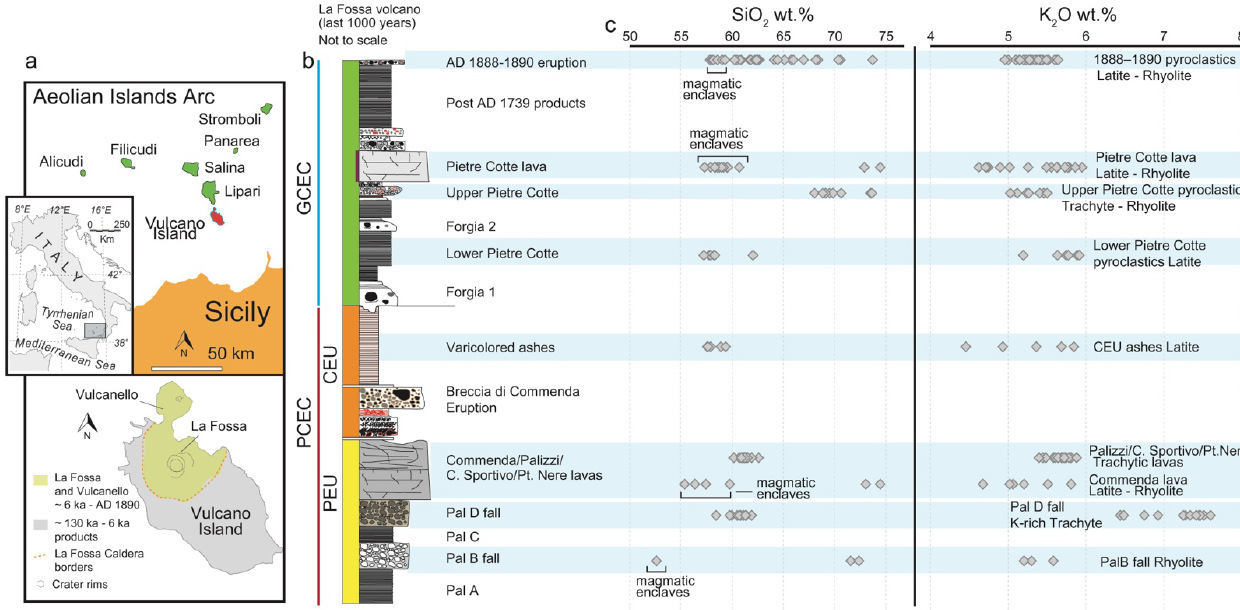
Figure 1. ( a ), Location of Vulcano in the Aeolian Arc and simplified sketch showing the location of La Fossa and Vulcanello eruptive centers; ( b ), stratigraphy for the products of the last 1000 years of La Fossa modified from [28]. See the review of [34] for a complete chronological framework; PCEC (Palizzi Commenda eruptive cluster), PEU (Palizzi eruptive unit), CEU (Commenda eruptive unit), GCEC (Gran Cratere eruptive cluster); ( c ), chemical stratigraphy (whole-rock) of erupted products from La Fossa Cone; literature data of ( c ): [19–22,27,35–41].